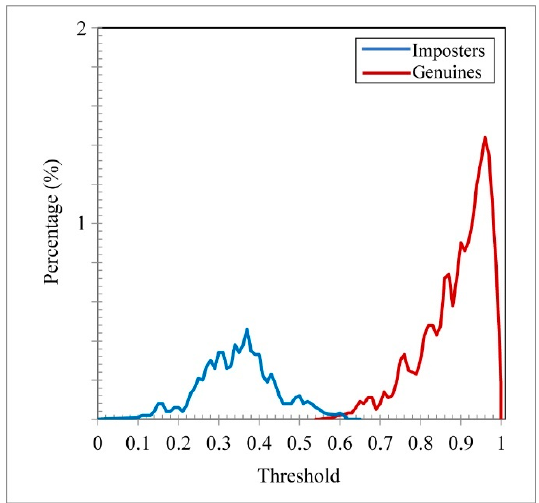
Figure 27. Distribution of genuine similarity score and distribution of impostor similarity score.